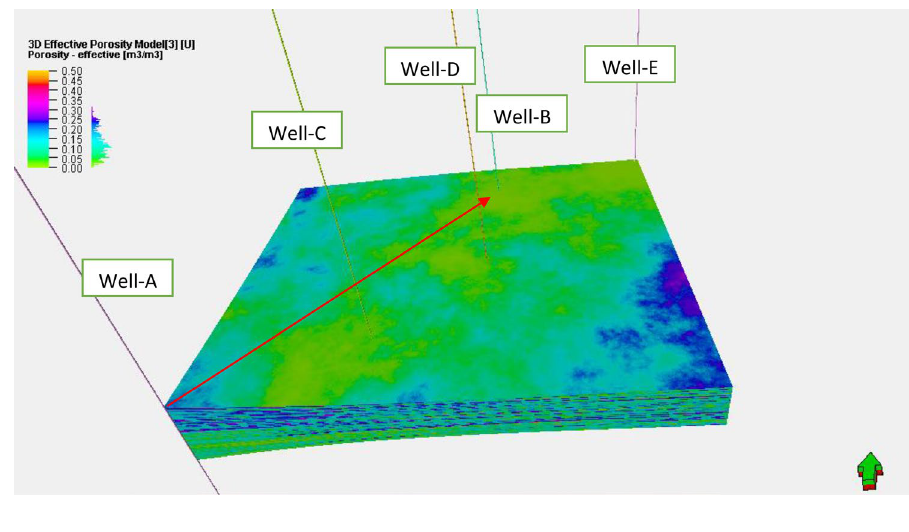
Fig. 19 3D hydrocarbon saturation model of the studied